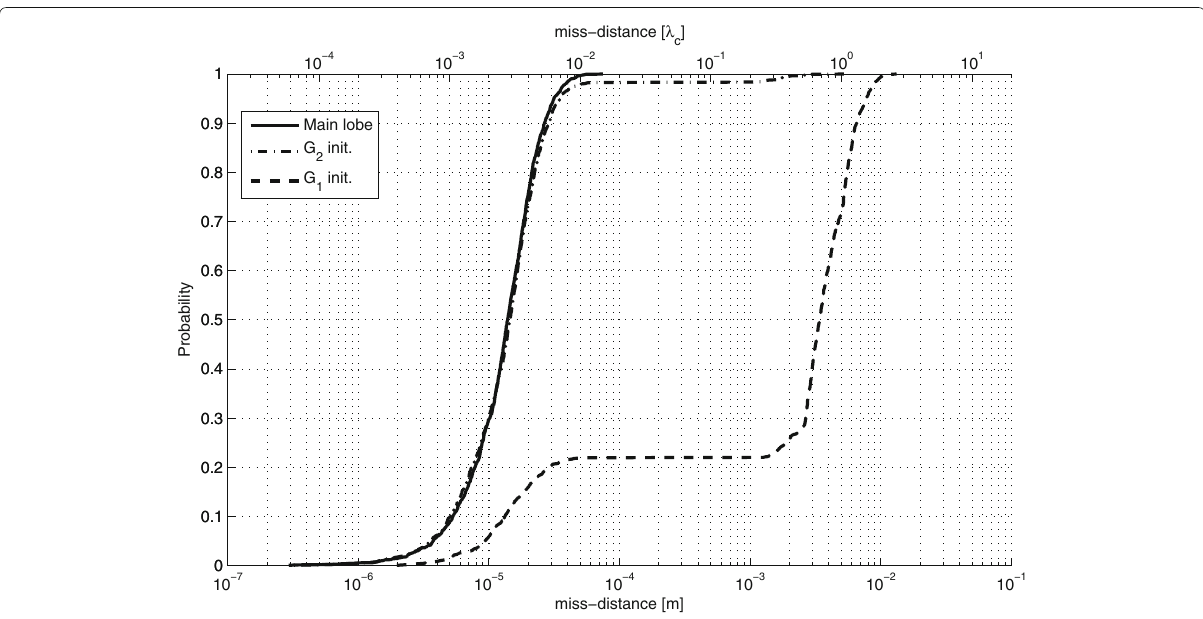
Fig. 20 Stage 3 error CDF curves for different initializations